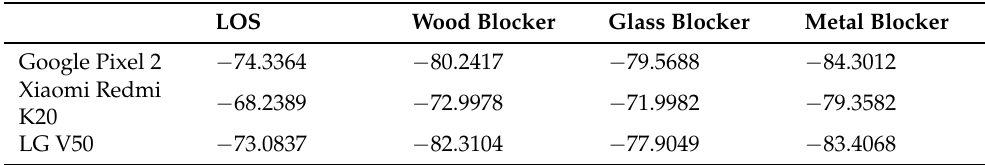
Table 2. Preliminary experimental results of the average RSSI